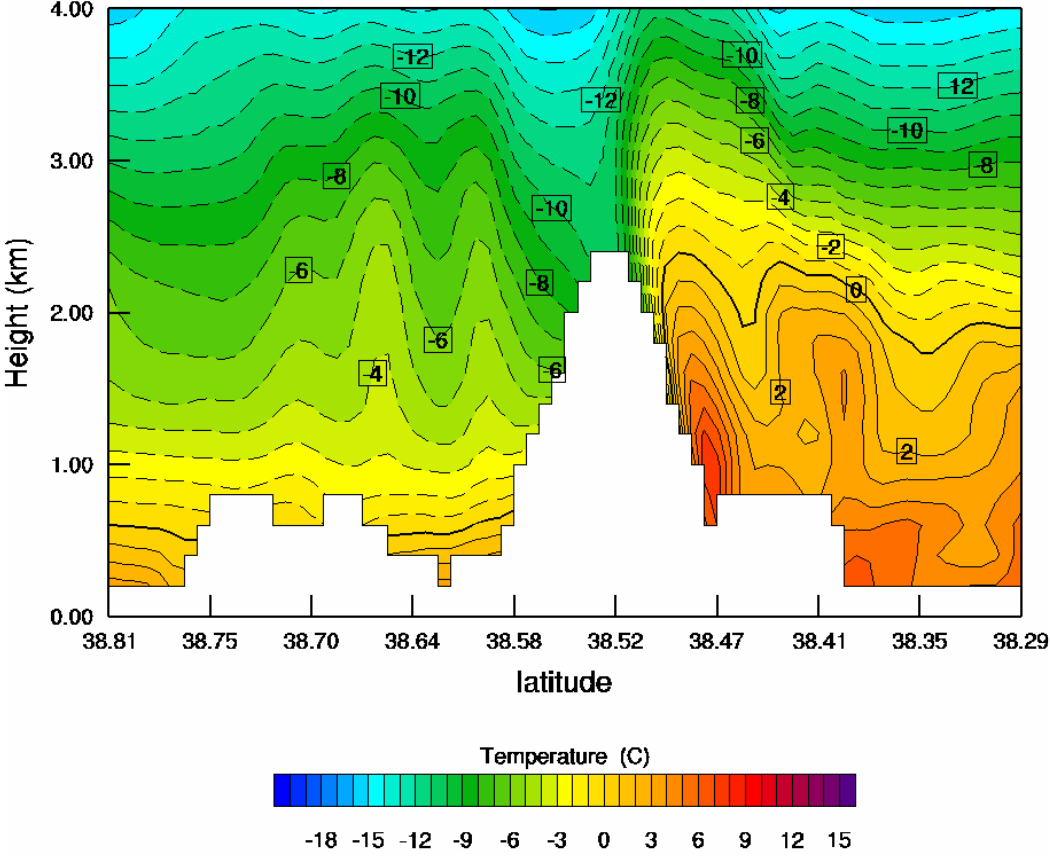
Figure 5. Modeled temperature in °C from the inner 1 × 1 km domain, along the cross-section shown in Figure 4a, 14 February 2019, 02:00 UTC.